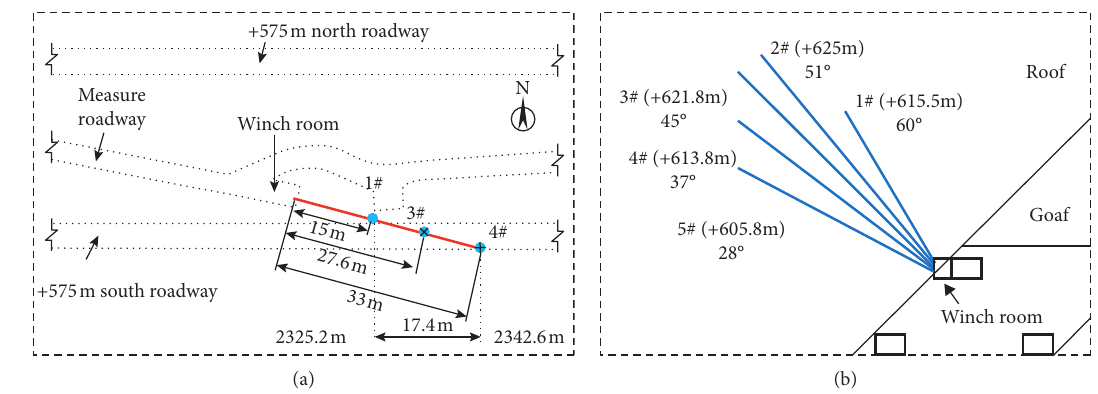
Figure 10: Layout of water outlet drilling in winch chamber. (a) plan; (b)